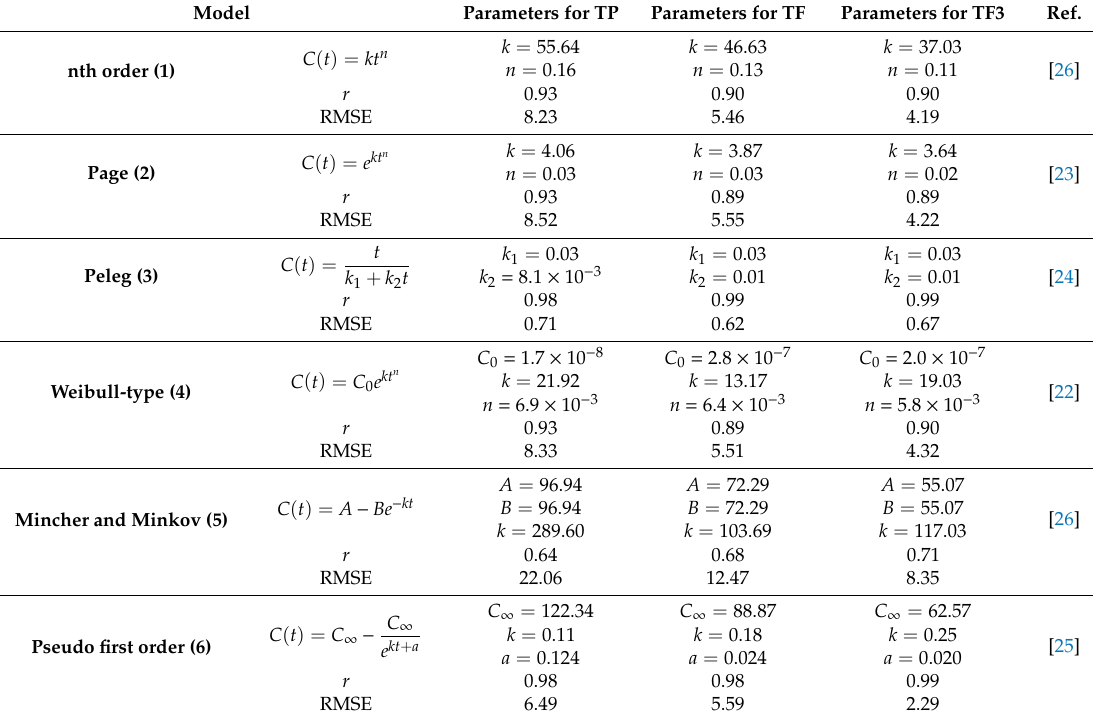
Table 3. Kinetic models used for the fitting for total polyphenol, total flavonoids, and total flavan-3-ols content from cocoa beans. Model